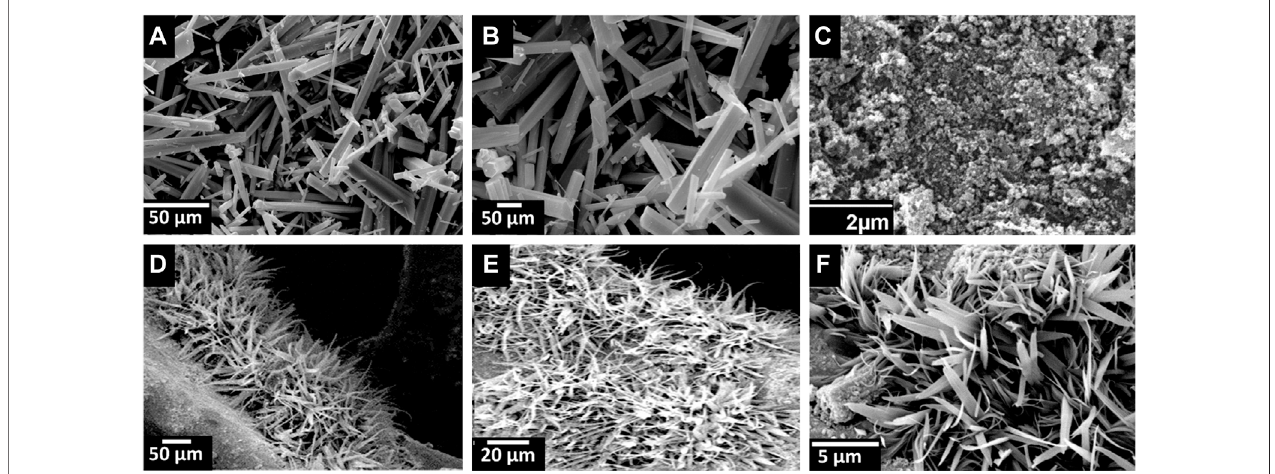
FIGURE 4 | SEM micrographs of MIL-68(In) is shown in (A) and (B) . Figure 4 (C) is Ag@In 2 O 3 and (D – F) shows Ag@In 2 O 3 coated on NF.